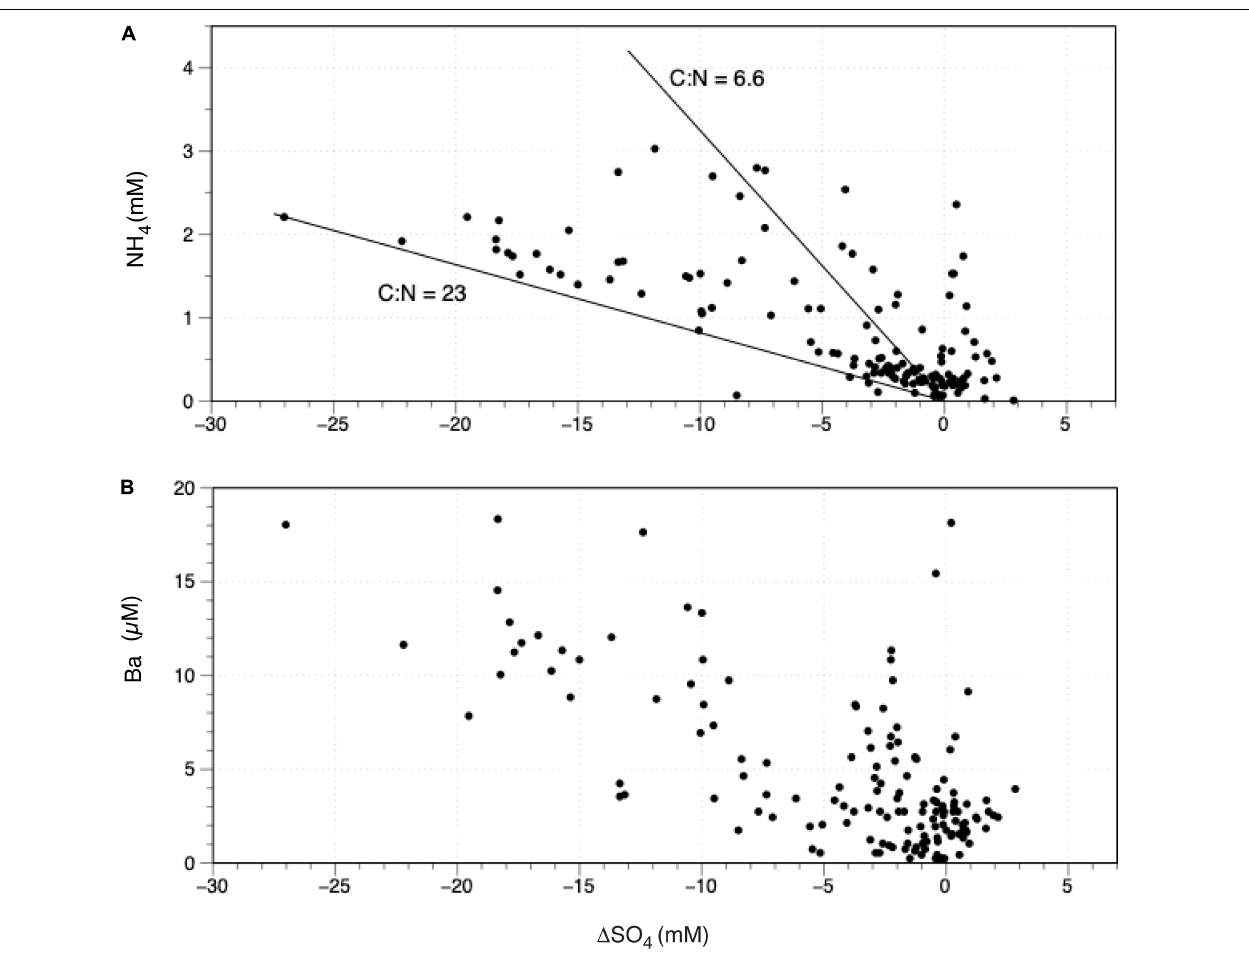
FIGURE 5 | Data from the IODP Exp 313, holes M0027A, M0028A, and M0029A on the continental shelf off New Jersey, showing the relationship between sulfate depletion by C oxidation (see text) and dissolved species in the upper levels of these cores. (A) The concentration of dissolved NH 4 + increases with sulfate depletion in a range between that predicted by oxidizing carbon with a 6.6 C:N ratio (Redfield Ratio) and a much higher ratio (23), implying the oxidation of non-marine carbon. (B) Dissolved Ba increases substantially with increased sulfate depletion, implying organic matter degradation releases significant Ba either directly or due to secondary reactions. High concentrations of NH 4 and Ba also exist in multiple samples showing no sulfate depletion, indication that other processes such as desorption or the release of sulfate from solid phases also play a role. Data from van Geldern et al. (2013), Integrated Ocean Drilling Program [IODP] (2020).